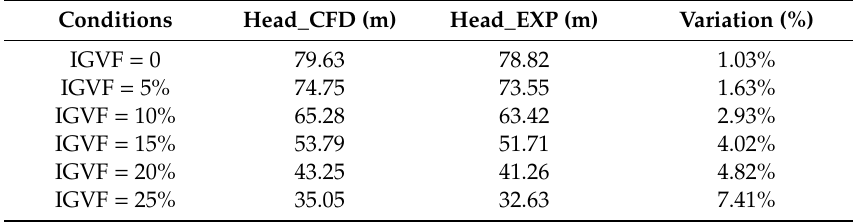
Table 3. Head data of the simulation (CFD) and experiment (EXP) under different inlet-gas-volume fractions (IGVFs).